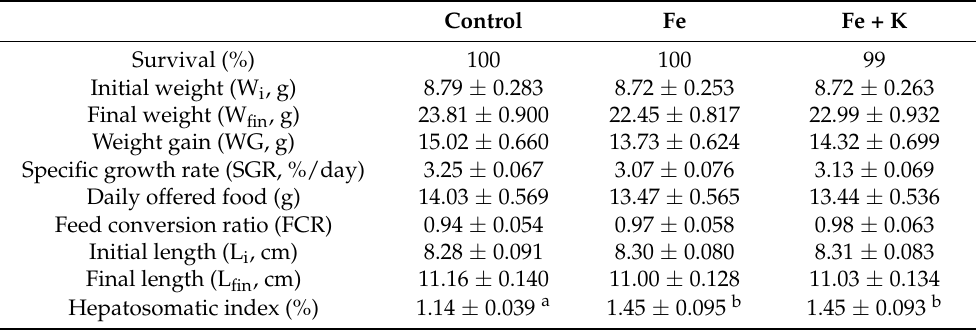
Table 3. Growth performance of red tilapia. Data are expressed as means ± S.E.M. Means in a row followed by different superscript are significantly different ( p > 0.05).